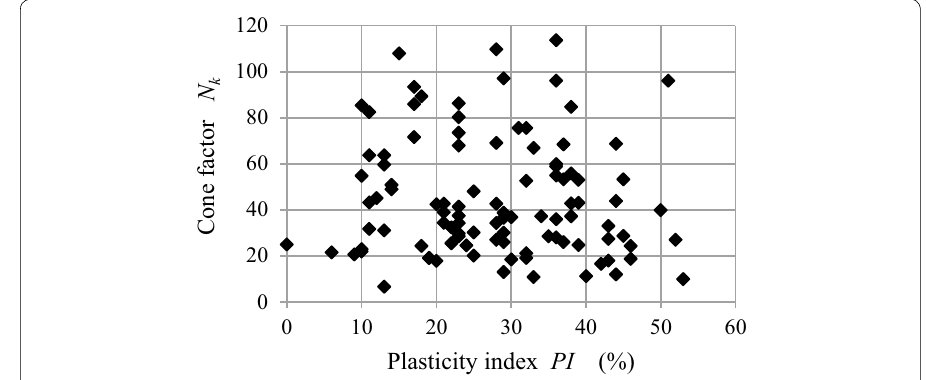
Fig. 4 Cone factor N k versus plasticity index PI for Sudanese